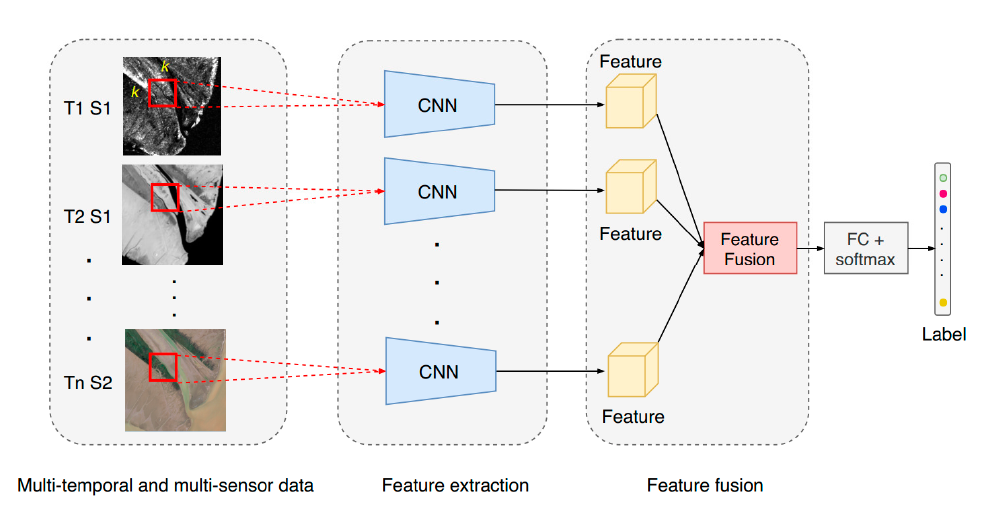
Table 2. Multitemporal Sentinel-1/2 data used in this study.